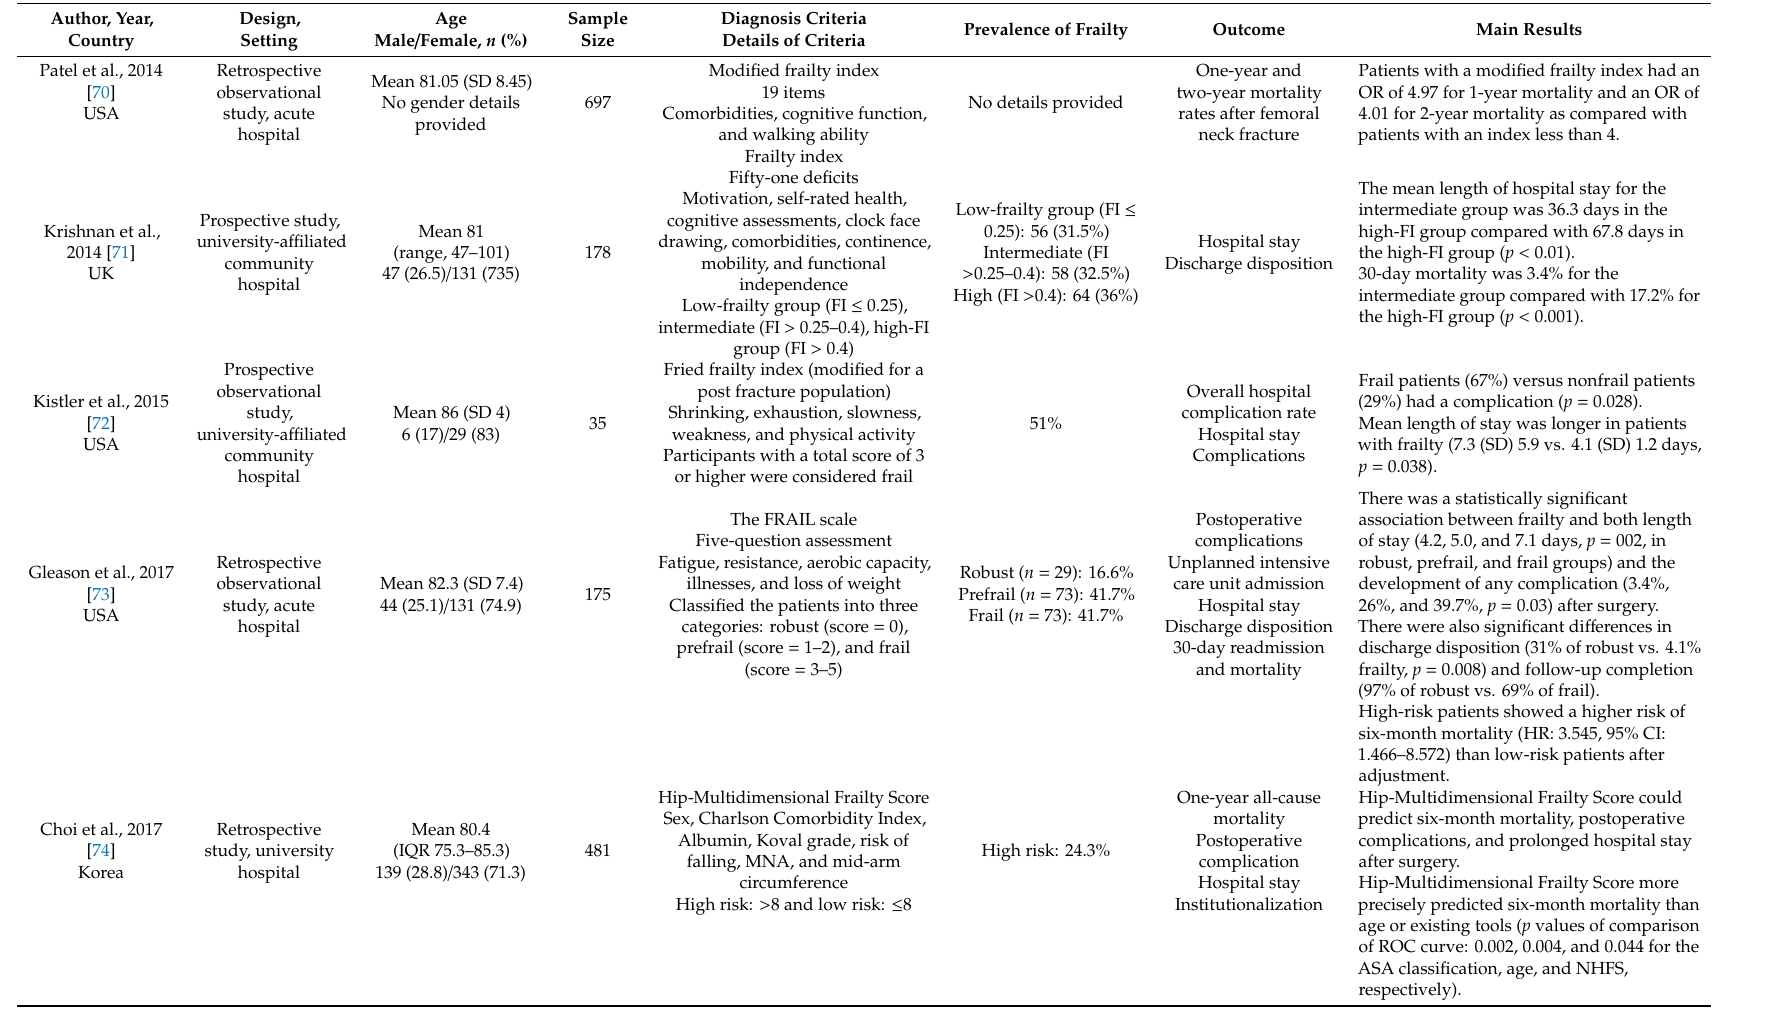
Table 3. Diagnosis criteria of frailty and its prevalence and impact on clinical outcomes in patients with hip